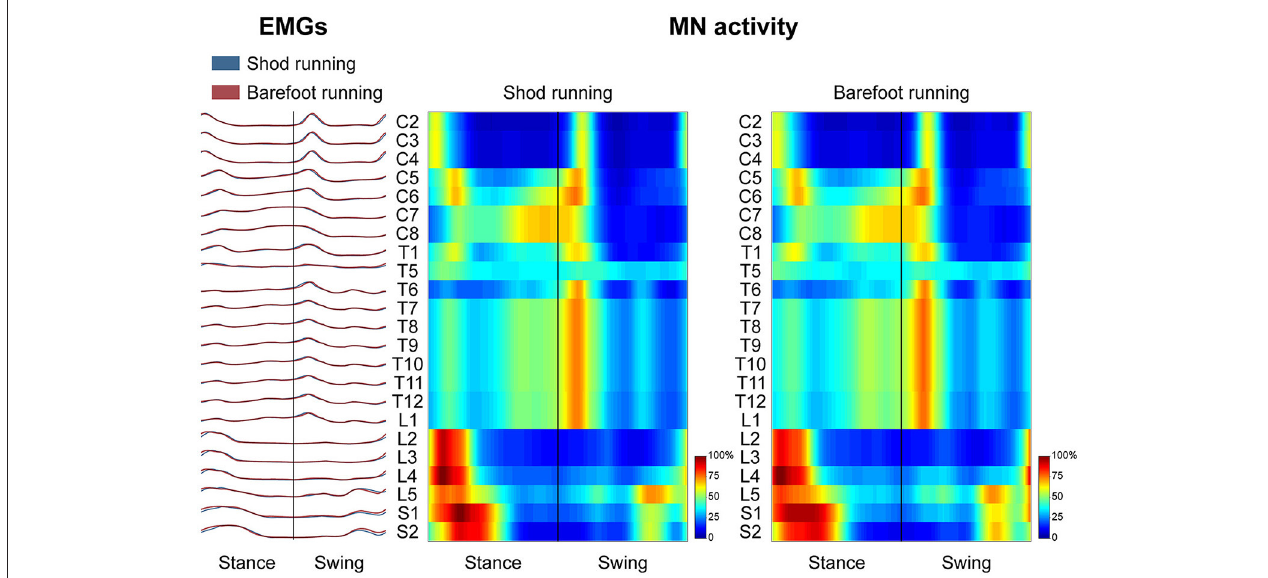
FIGURE 3 | The average spatiotemporal spinal motor output is presented for shod and barefoot running, normalized in amplitude to the maximum of each segment. These curves have been obtained by mapping each of the 24 muscle activations onto the relative spinal segment (cervical from C2 to C8, thoracic from T1 to T12, lumbar from L1 to L5 and sacral from S1 and S2). The two level plots show the average alpha-motoneurons activity for each condition, giving additional information about the absolute activation level (normalization to the maximum of each condition). The stance and swing phases have been temporally normalized to the same amount of data points (100 each). Values are the means across all subjects and all